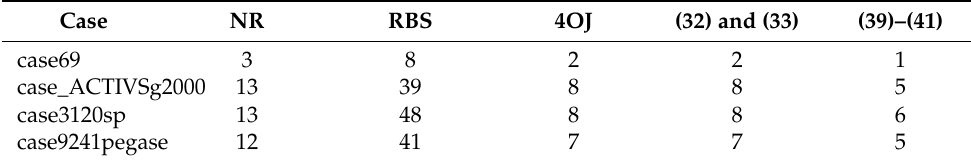
Table 5. Total iterations for well-conditioned cases with reactive limits.